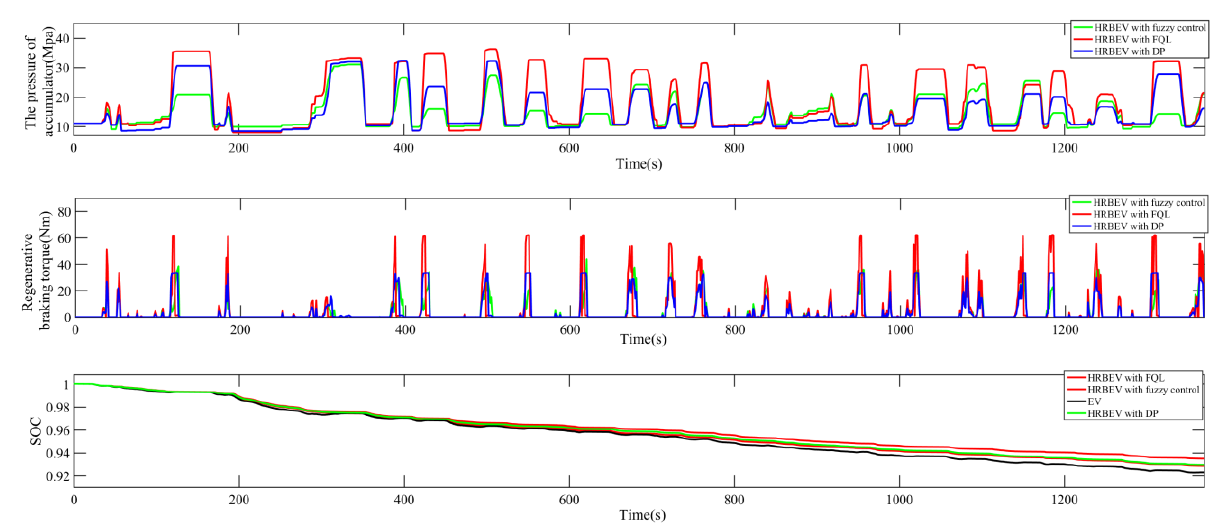
Figure 12. Simulation results under the UDDS